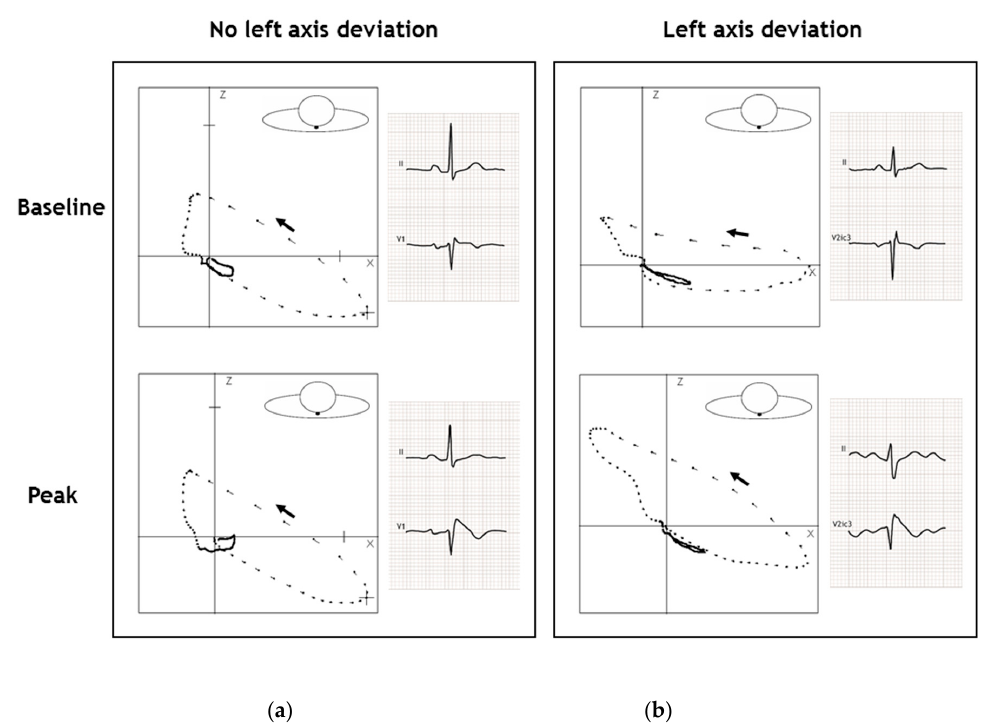
Figure 2. The QRS-T loop in the transverse plane of two representative patients at baseline and ajmaline peak. ( a ) Patient without a left axis deviation. The QRS-axis in the frontal plane changed 3 ° to the left. At baseline, the QRS-duration was 94 ms and increased to 106 ms at ajmaline peak; the changes in the duration of the quartiles of the QRS-loops were: q1 +0 ms, q2 +2 ms, q3 +2 ms and q4 +8 ms. The QRS-T angle changed with –19 ° from 27 ° at baseline to 8 ° at ajmaline peak; ( b ) Patient with a left axis deviation. The QRS-axis in the frontal plane changed 60 ° to the left. At baseline, the QRS-duration was 92 ms and increased to 138 ms at ajmaline peak; the changes in the duration of the quartiles of the QRS-loops were: q1 +14 ms, q2 -2 ms, q3 +18 ms and q4 +16 ms. The QRS-T angle changed with +60 ° from 40 ° at baseline to 100 ° at ajmaline peak. Dashes of the QRS-T loop: 2-ms intervals. The black arrow indicates the QRS-loop direction. Int. J. Mol. Sci. 2021 , 21 , x FOR PEER REVIEW